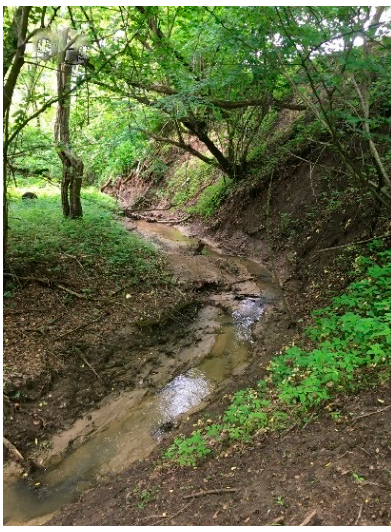
Figure 14. Fel ţ a River non-refuge sector. Figure 14. Fel¸ta River non-refuge